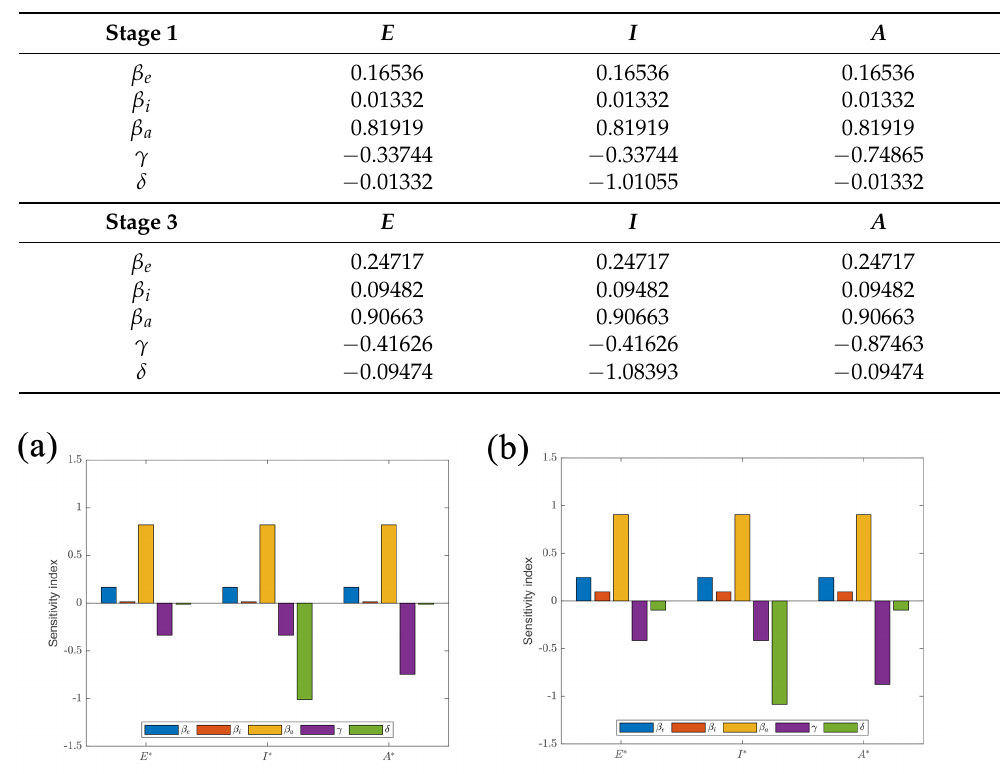
Table 3. Sensitivity indices of endemic equilibrium ( E , I , A ) in response to the model parameters in three stages.